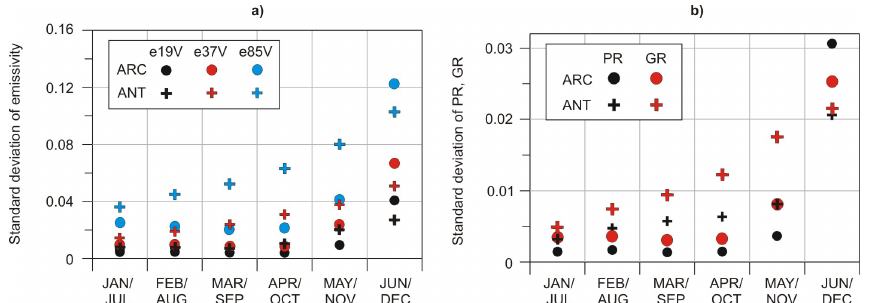
Fig. 6. Seasonal evolution of simulated, monthly standard deviations of (a) emissivities at 19 (black), 37 (red) and 85GHz (blue), each at vertical polarization, for the Arctic (circles) and Antarctic (crosses) and (b) PR (black) and GR (red) for the Arctic (circles) and Antarctic (crosses). Monthly values, characterizing the diurnal, regional and inter-annual variabilities, January to June (Arctic) and July to December, Antarctic,